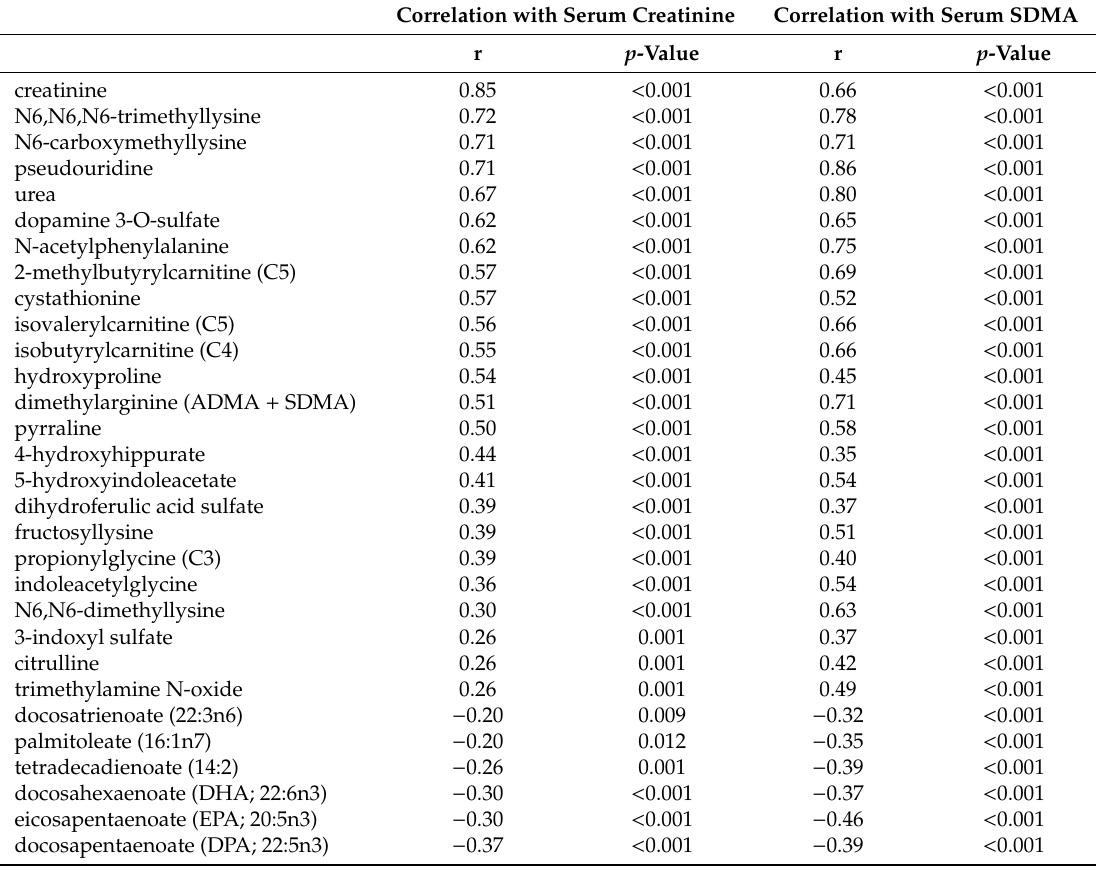
Table 5. Correlations of plasma metabolites with serum creatinine and serum SDMA. Correlation with Serum Creatinine Correlation with Serum SDMA